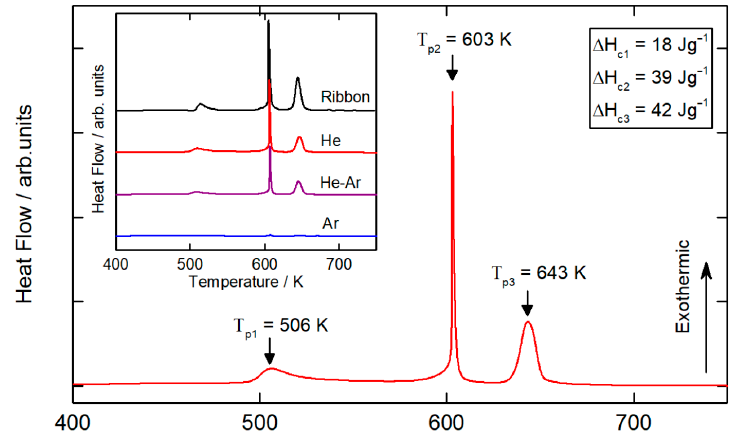
Figure 5. DSC measurements for 75–45 μ m particles atomized in a He atmosphere at 40,000 rpm. Δ H c1 , Δ H c2 , and Δ H c3 are the integrated enthalpies of crystallization for the first, second, and third peaks, respectively. Inset in the figure shows the DSC curves of the respective samples atomized in different gas compositions, and DSC curve of ribbon sample is adapted from [26].